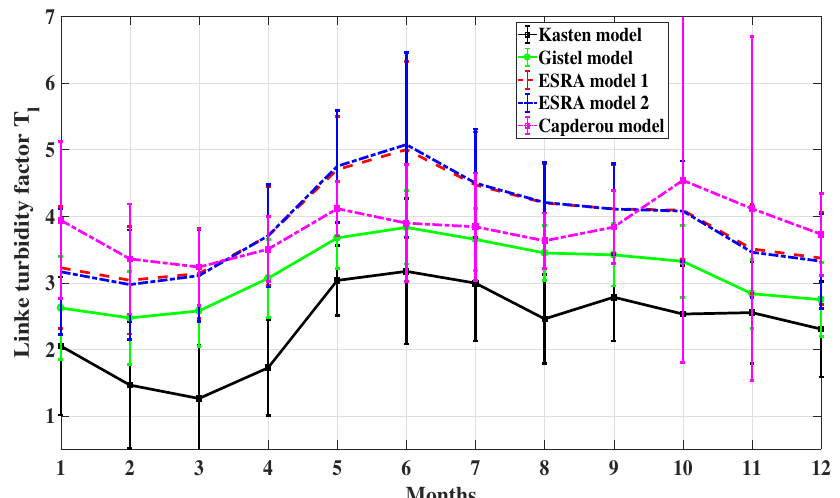
Figure 3. Monthly average of the Linke turbidity factor.